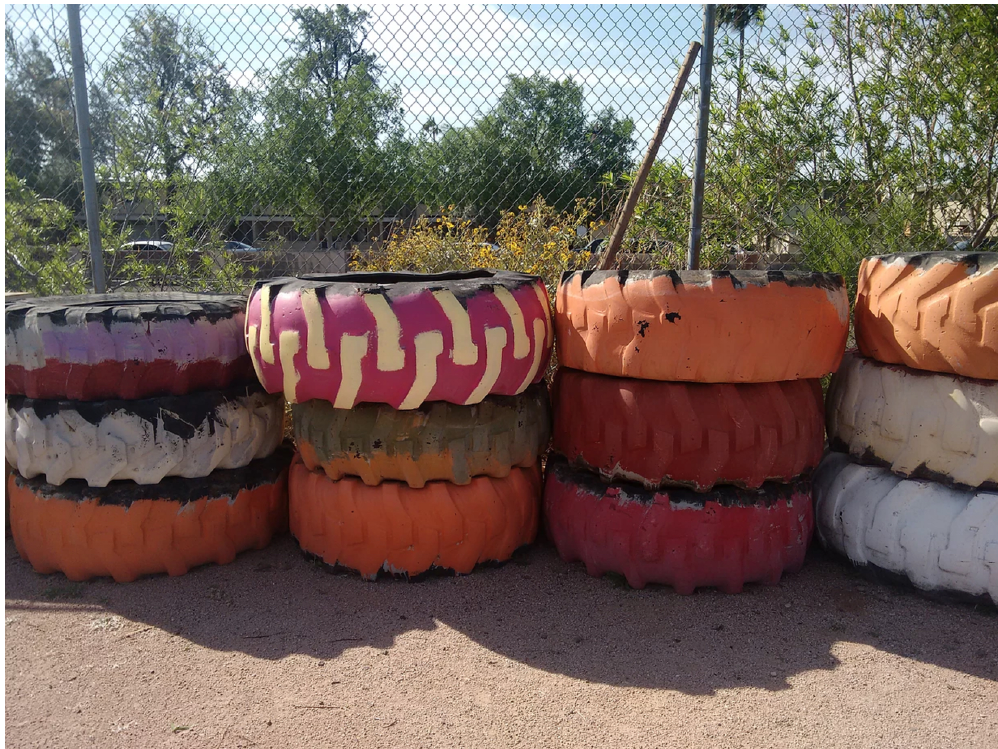
Figure 8. Four abandoned tires being used as